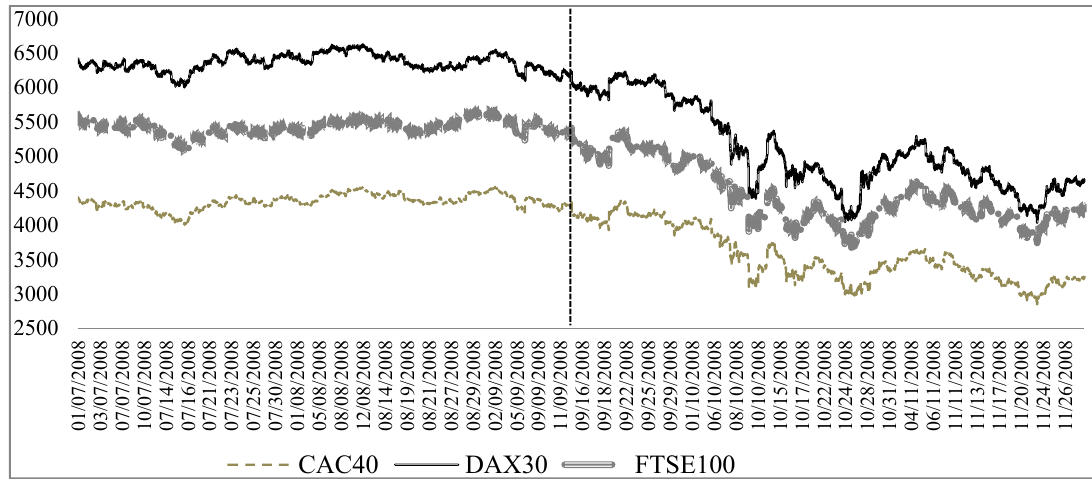
Figure 1. The evolution of European stock markets indices (1 July 2008 to 28 November